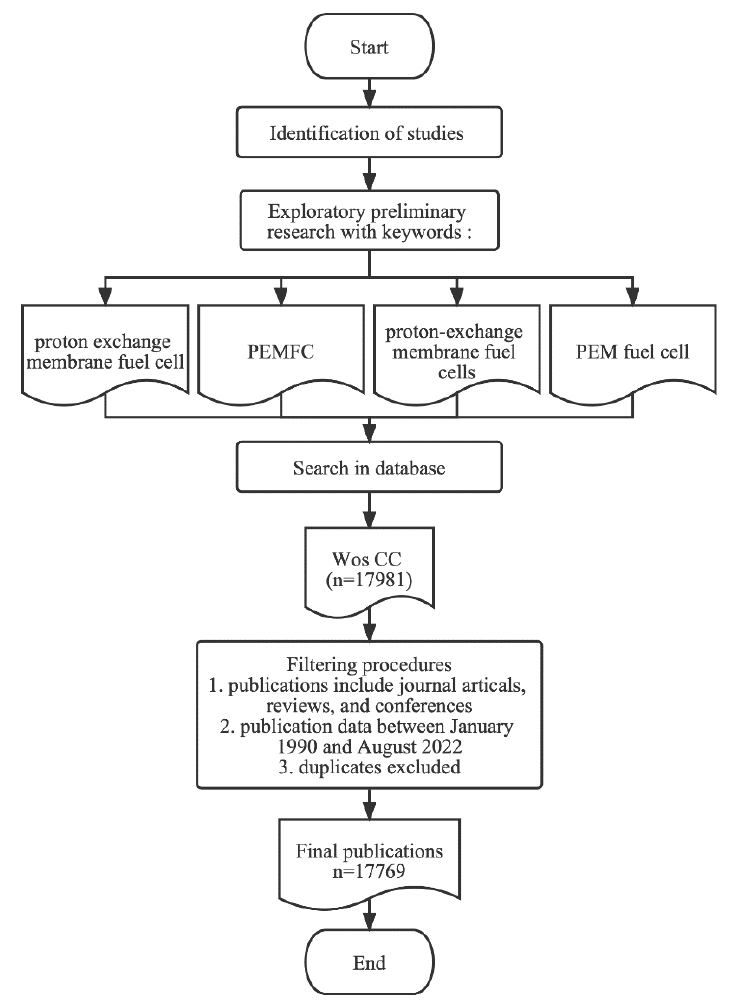
Figure 1. Flow chart of a systematic